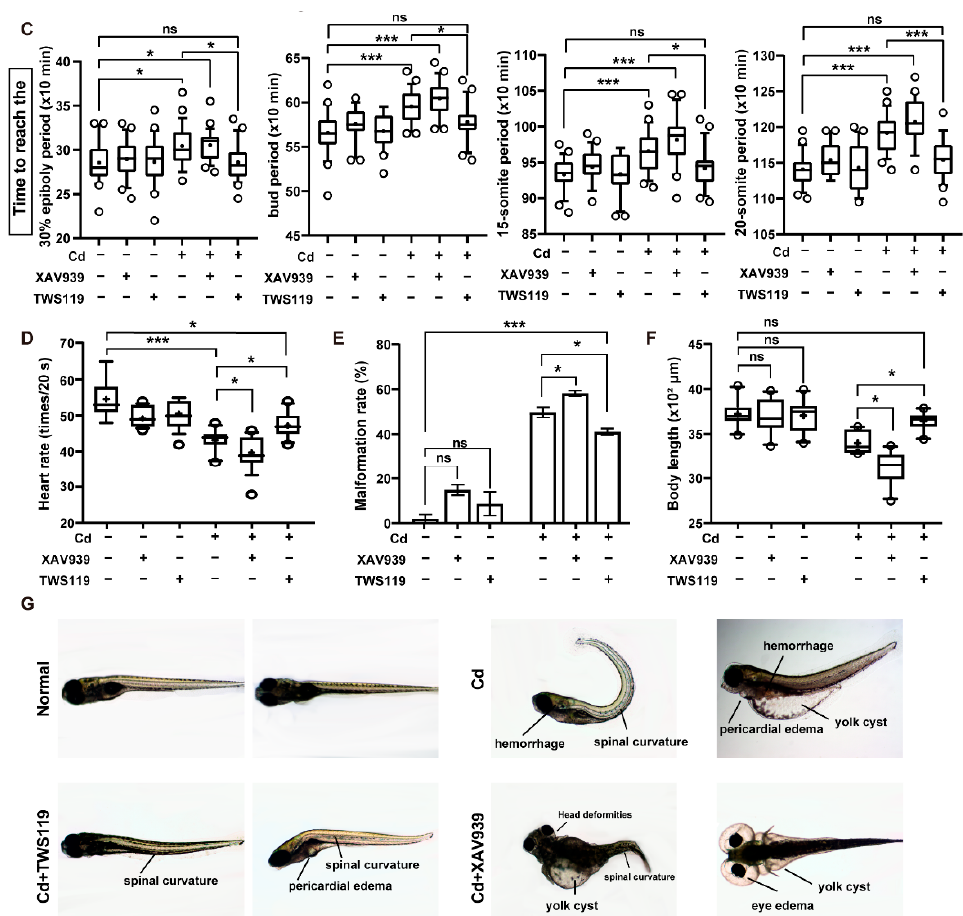
Figure 2. Activation of Wnt signaling pathway attenuated the adverse effects of Cd 2+ on zebrafish early development. ( A ) Schematic design for the following study. ( B , C ) High-throughput tracking (representative images) of zebrafish early development, and the duration for embryos in different groups to reach certain stages. ( D – F ) Heart rate, rate of deformed individuals, and body length of 6 dpf zebrafish in different groups. ( G ) Representative morphological characteristics of zebrafish larvae in each group. The values are presented in boxplots (median and mean, whiskers show 90% confidence levels) or in histograms (mean ± SEM). The results of either nonparametric test or ANOVA followed by multiple comparison test are listed in Table S2. “*” indicates significant differences (* p < 0.05, *** p < 0.001).